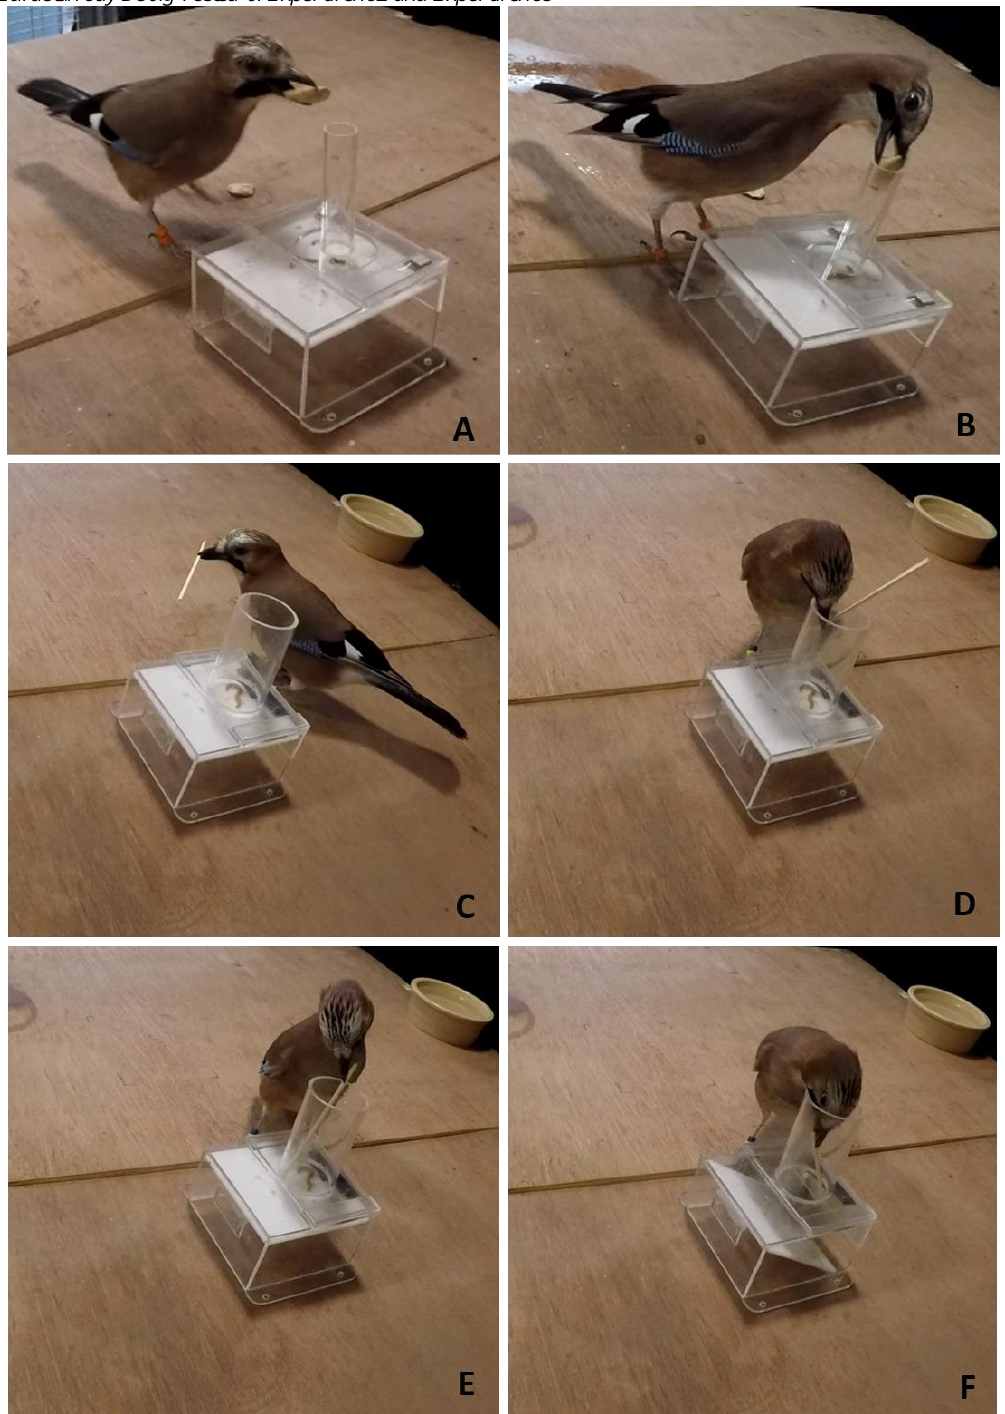
Eurasian Jay Being Tested in Experiment 2 and Experiment